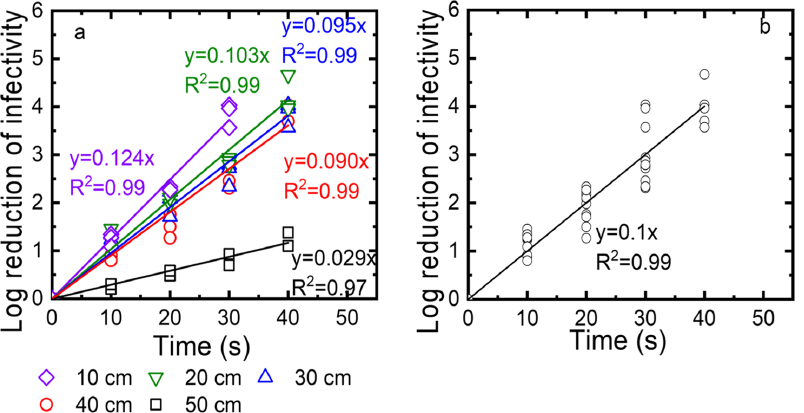
Figure 8. ( a ) TV inactivation as a function of time measured for different distances (10, 20, 30, 40 cm). ( b ) Linear regression for TV inactivation as a function of time measured for distances of 10, 20, 30, and 40 cm. Log reduction of infectivity is log 10 (N0/N), with N0 as the infectivity of the viral suspension before exposure to UV and N as the infectivity of this suspension after UV exposure.